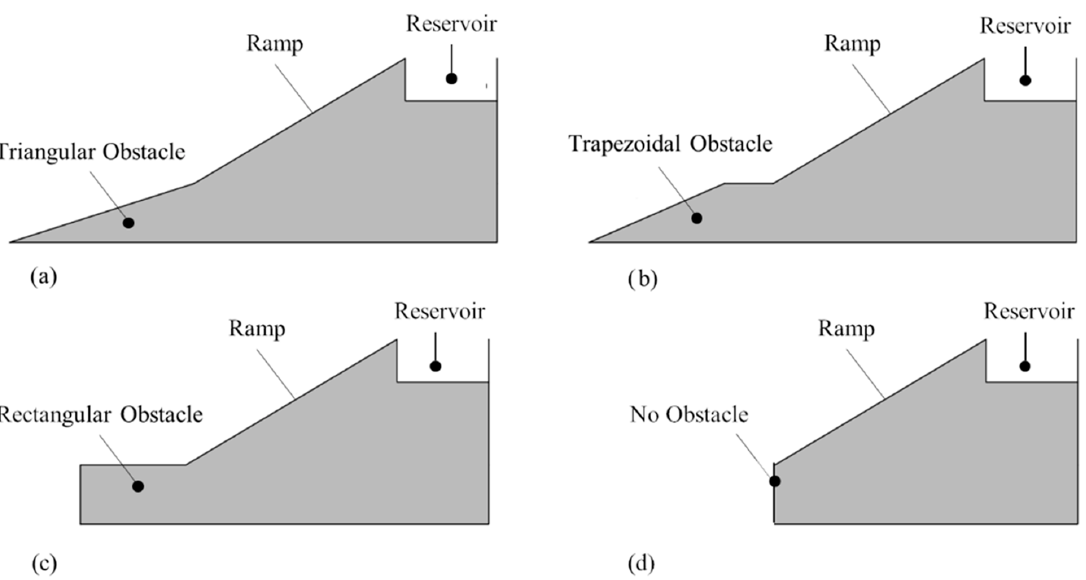
Figure 2. Geometric configurations of the obstacle and case without the obstacle: ( a ) triangular; ( b ) trapezoidal; ( c ) rectangular; and ( d ) no